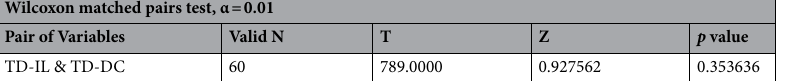
Table 2. Wilcoxon Matched Pairs Test performed for tangential dimension of two radial files adjacent to intrusively growing initial together with tangential dimension of intrusively growing tip of initial—measured in initial layer (TD-IL), and tangential dimension of the same two radial files distanced from initial layer (TD- DC).